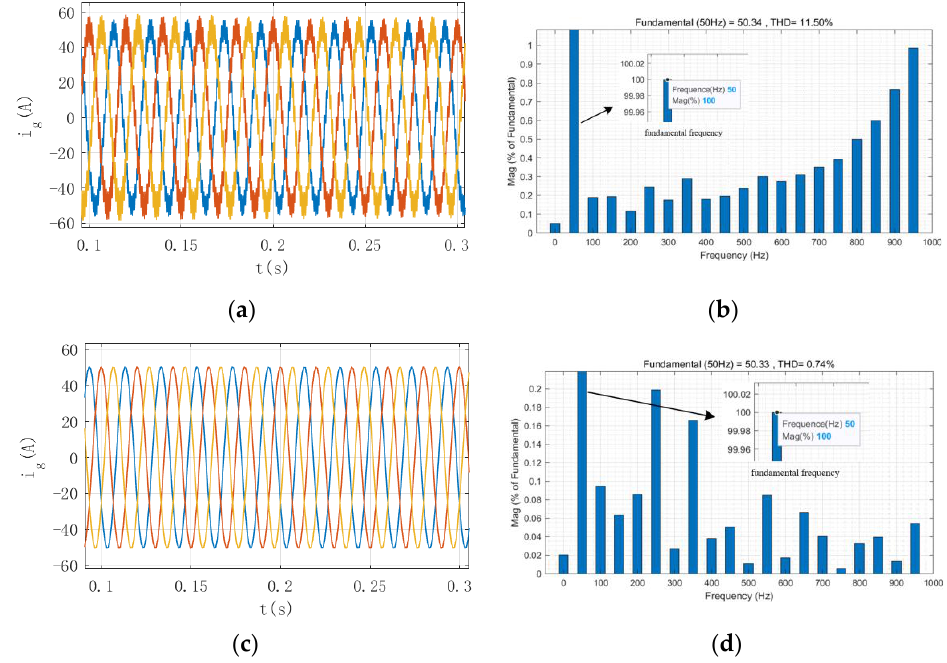
Figure 10. Grid current without passive damping and with passive damping. ( a ) Current without passive damping; ( b ) THD diagram without passive damping;( c ) Current with passive damping;( d ) passive damping; ( b ) THD diagram without passive damping; ( c ) Current with passive damping; THD diagram with passive damping. ( d ) THD diagram with passive